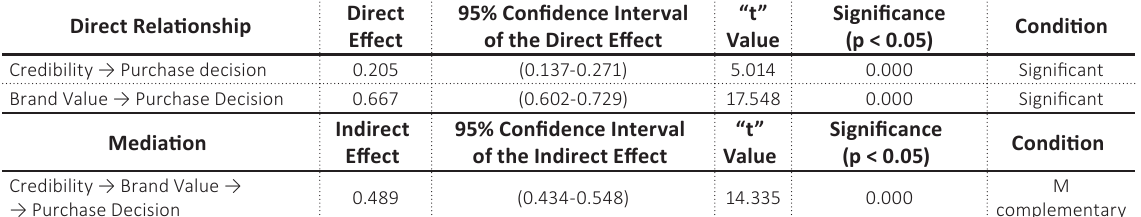
Table 5. Brand equity mediation